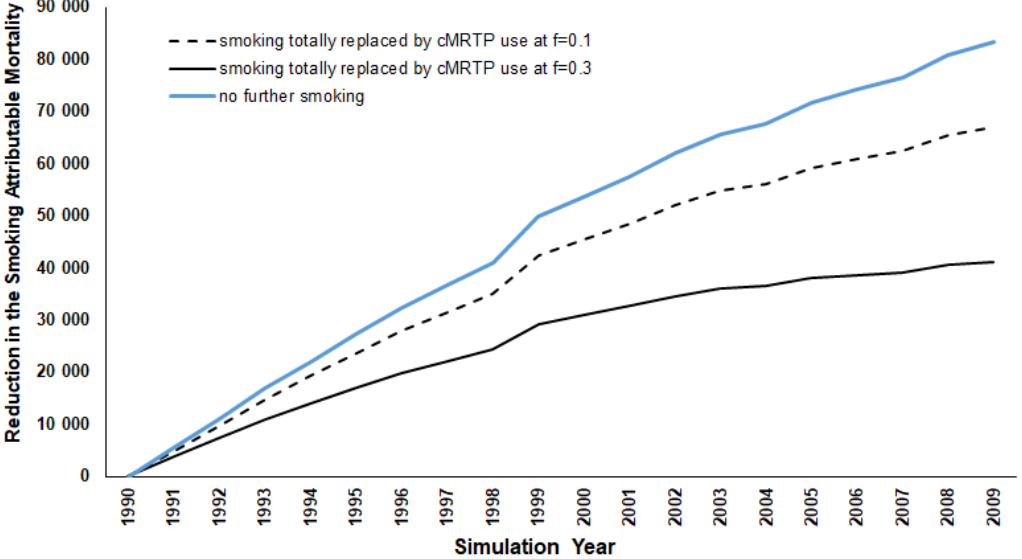
Figure 1. Annual reduction in SADs from 1990 to 2009 for alternative for alternative scenario 1, “No further smoking,” and scenario 2 “Smoking totally replaced by cMRTP use at f = 0.1 and f = 0.3.” For all years combined, the reductions are 516,944 and 780,433 deaths. The line for the “no further smoking “scenario is superimposed.